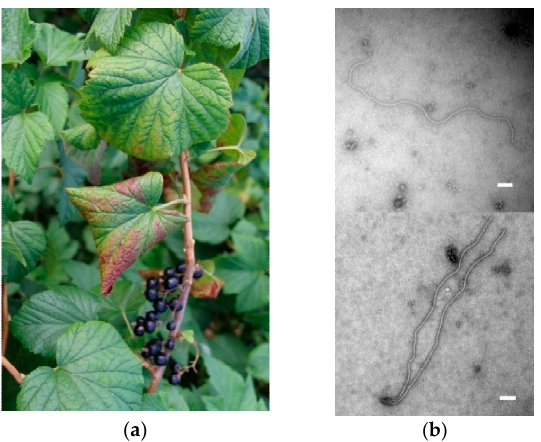
Figure 6. ( a ) Leafroll symptoms on the black currant plant, 28074: downward curling of leaf margins and interveinal red coloration (Switzerland, July 2017); ( b ) individual particles obtained after viral particle enrichment of the black currant 28074 leaf material. The scale bar represents 100 nm.